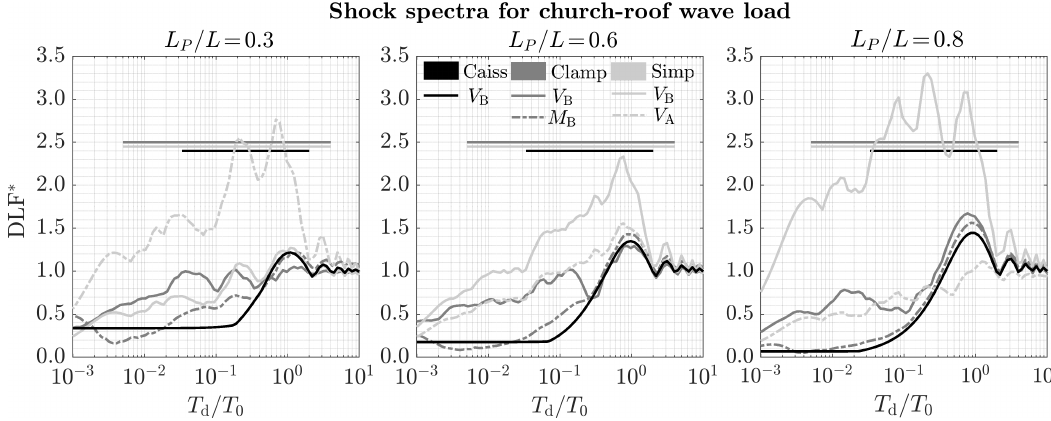
Figure 13. Shock spectra for different structural types and support reactions as a function of relative moment arm L P / L . Horizontal lines define the full range of design situations which are most likely to be observed in